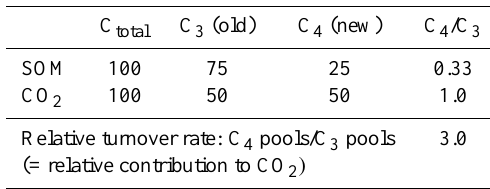
Fig. 4. Abrupt temporary impact of isotopic signature of C input (above) and its effect on changes of isotopic signature of soil organic matter (below). The change of isotopic signature is presented for bulk SOM (fat curve), as well as for pools with slow and fast turnover (dotted lines). The hight of vertical arrows and the shaded area showing the differences in isotopic signature between the slow and fast pools is proportional to the sensetivity of the approach for each period. The dashed horizonthal arrows show the time lag between the impact and the maximal change of isotopic signature of the pool. Explanations in text. Isotopic fractionations are not considered here, and theredore the SOM pools have identical isotopic compositions before the impact and at new steady state.